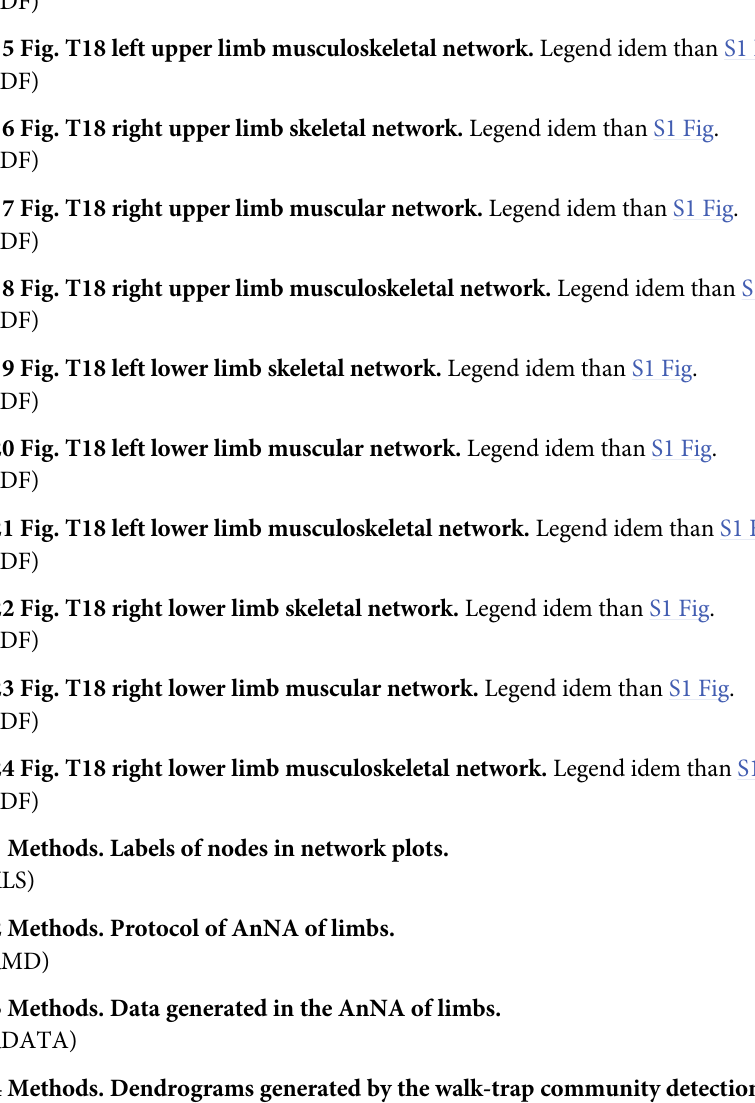
S14 Fig. T18 left upper limb muscular network. Legend idem than S1 Fig. (PDF) S15 Fig. T18 left upper limb musculoskeletal network. Legend idem than S1 Fig. (PDF) S16 Fig. T18 right upper limb skeletal network. Legend idem than S1 Fig. (PDF) S17 Fig. T18 right upper limb muscular network. Legend idem than S1 Fig. (PDF) S18 Fig. T18 right upper limb musculoskeletal network. Legend idem than S1 Fig. (PDF) S19 Fig. T18 left lower limb skeletal network. Legend idem than S1 Fig. (PDF) S20 Fig. T18 left lower limb muscular network. Legend idem than S1 Fig. (PDF) S21 Fig. T18 left lower limb musculoskeletal network. Legend idem than S1 Fig. (PDF) S22 Fig. T18 right lower limb skeletal network. Legend idem than S1 Fig. (PDF) S23 Fig. T18 right lower limb muscular network. Legend idem than S1 Fig. (PDF) S24 Fig. T18 right lower limb musculoskeletal network. Legend idem than S1 Fig. (PDF) S1 Methods. Labels of nodes in network plots. (XLS) S2 Methods. Protocol of AnNA of limbs.